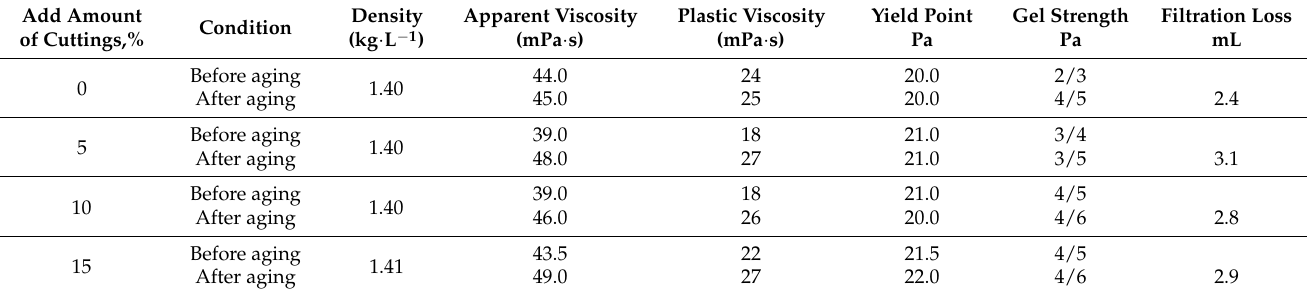
Table 5. Evaluation of Anti-pollution capability of cuttings between before/after optimization of solid-free organic salt drilling fluid.